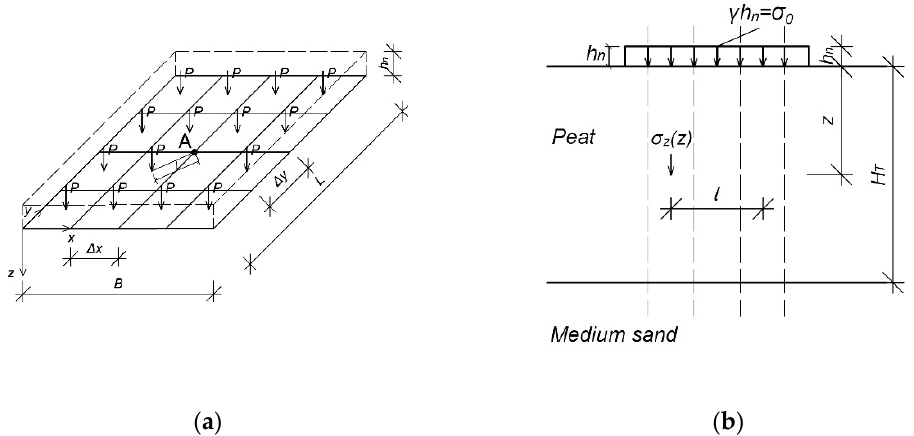
Figure 6. Influence of the calculation areas on each other: ( a ) division of the embankment into calculation areas and distance of the force to the point; ( b ) cross-section. P , force (kN); l , distance from an analysed point to force (kN); A , analysed point ( − ); B , width of the embankment (m); L , length of the embankment (m); x , axis of width; y , axis of depth; z , axis of depth; Δ x , width of the mesh element; Δ y , length of the mesh element; h n , height of the embankment (m); γ , weight of the embankment (kN m − 3 ); σ 0 , loaded with the embankment (kPa); H T , thickness of the organic soil (m); σ z , stresses in the soil (kPa).